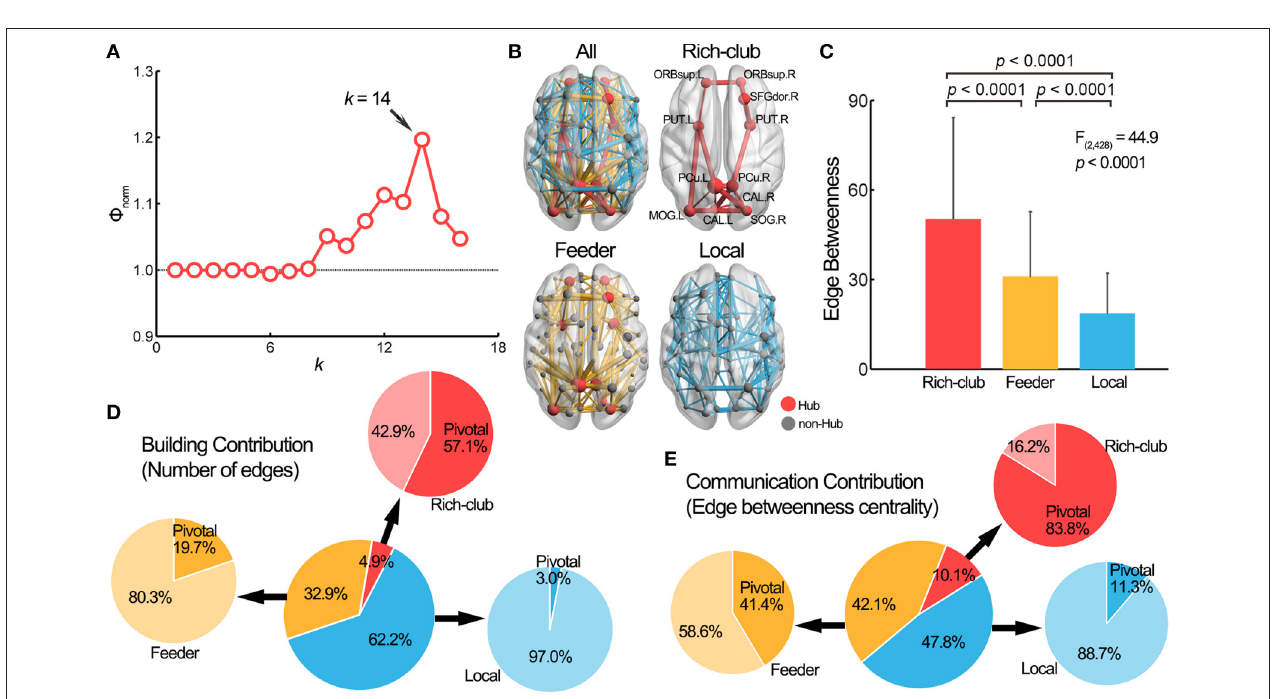
FIGURE 3 | Contribution of the pivotal edges toward the centrality of the nodes they linked. The pivotal edges had significantly greater contributions to all three nodal properties (nodal degree, efficiency, and betweenness) than the non-pivotal ones. The contribution toward nodal centralities of an edge was estimated by averaging nodal properties of its two linking nodes.